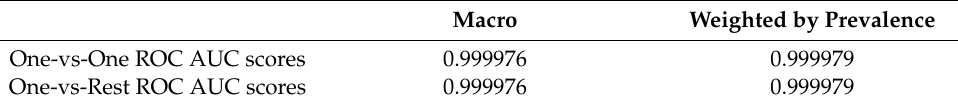
Table 7. The accuracy of the proposed system on the first session dataset. Macro Weighted by Prevalence One-vs-One ROC AUC scores